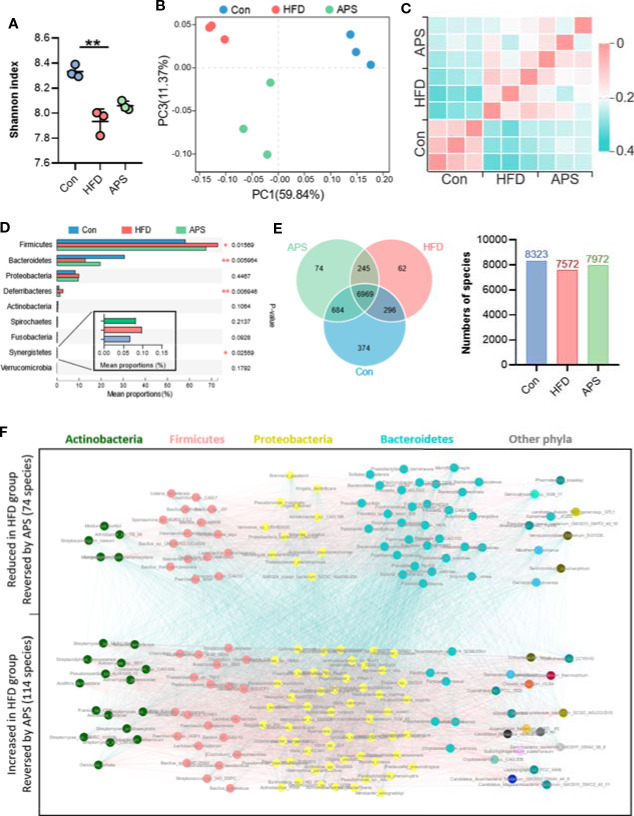
APS reverses gut dysbiosis in HFD-fed mice. Cecum samples of Con, HFD, and APS groups were analyzed with metagenomics. (A) Shannon index. (B) Bray_curtis based PCoA analysis followed by Permutational Multivariate Analysis Of Variance (PERMANOVA, R2: 0.695, p-value: 0.005, p.adjust: 0.005). (C) Bray_curtis based distance matrix. (D) Multigroup difference analysis of the top 9 abundant phyla. (E) Venn diagram illustrating the overlap of species in intestinal microbiota among the samples and number of species in three groups. (F) Co-occurrence network deduced from 188 differential species significant changed in HFD group compared to Con group and restored in APS group. Red edges, Spearman's rank correlation coefficient > 0.8, p < 0.01; blue edges, Spearman's rank correlation coefficient < −0.8, p < 0.01. n = 3 per group. **p < 0.01.